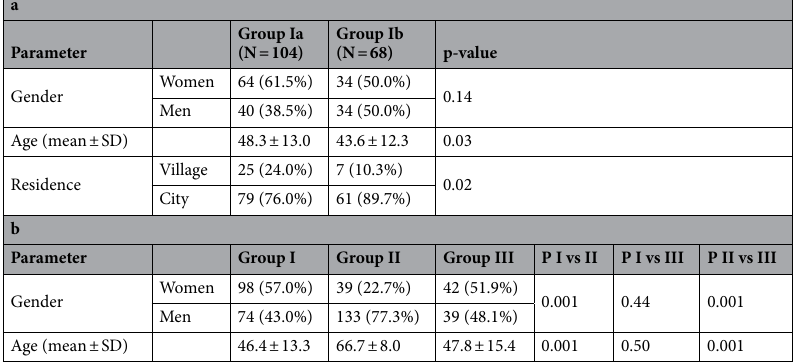
Table 1. Demographic data and descriptive